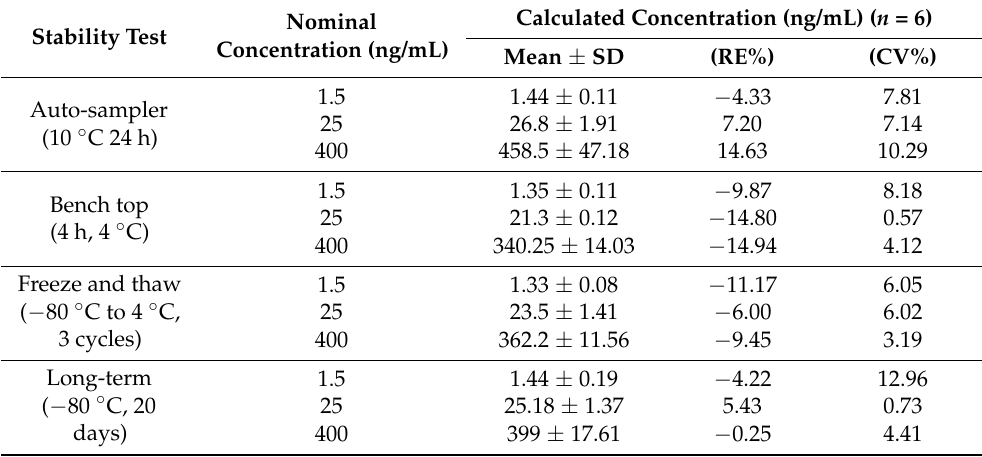
Table 4. Stability data for MPI8 in rat